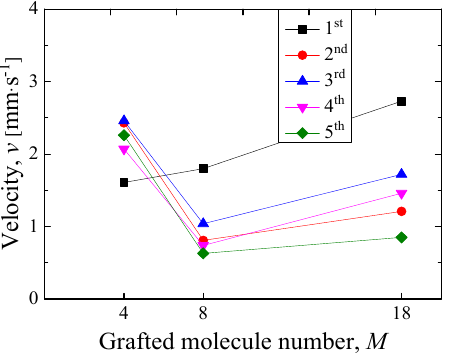
Figure 8. Experimental values of the operating speed of 10-100 C M silica gel CDs.